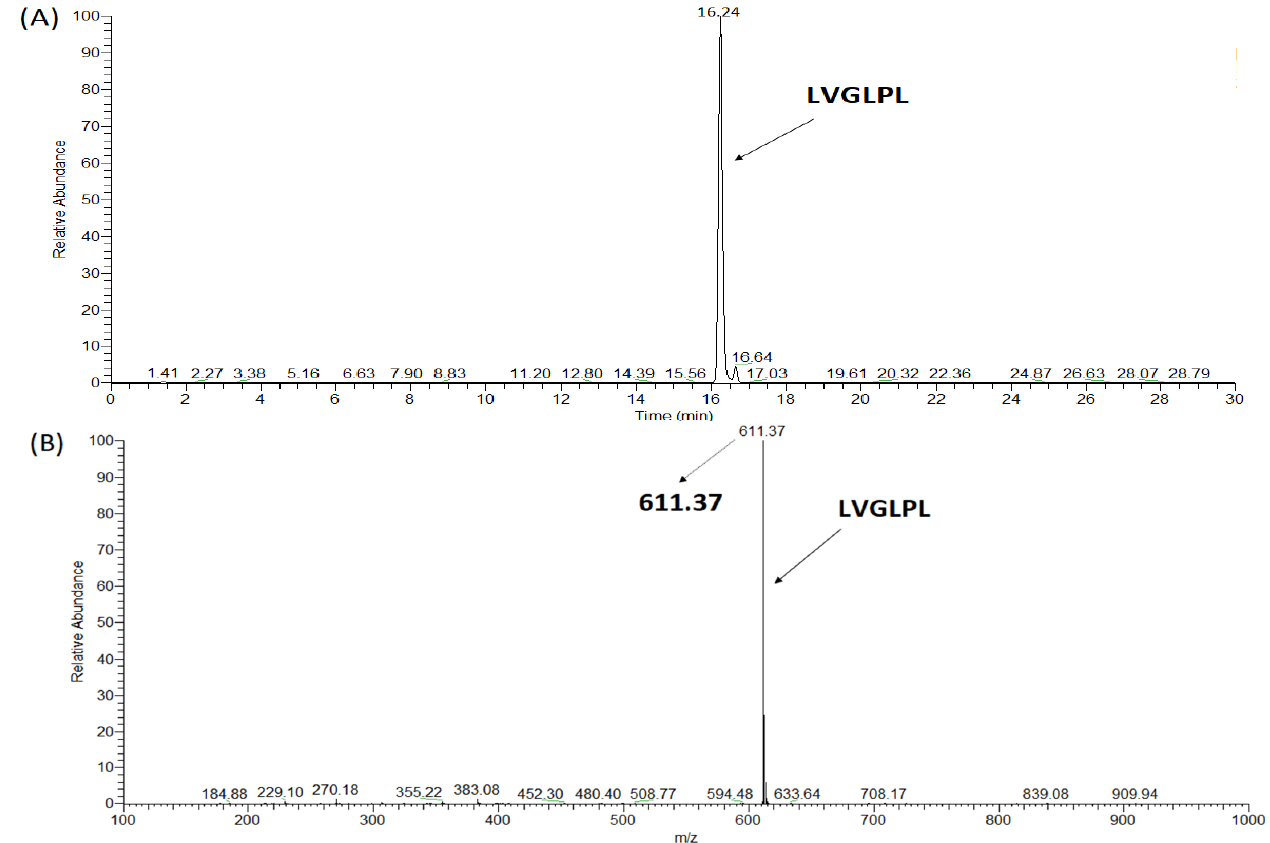
Figure A5. The stability of LVGLPL against the ACE activity under the pre ‐ incubation condition with ACE. ( A ) LC ‐ MS analysis of LVGLPL. ( B ) The MS spectrum of fragment LVGLPL (m/z 611.37).